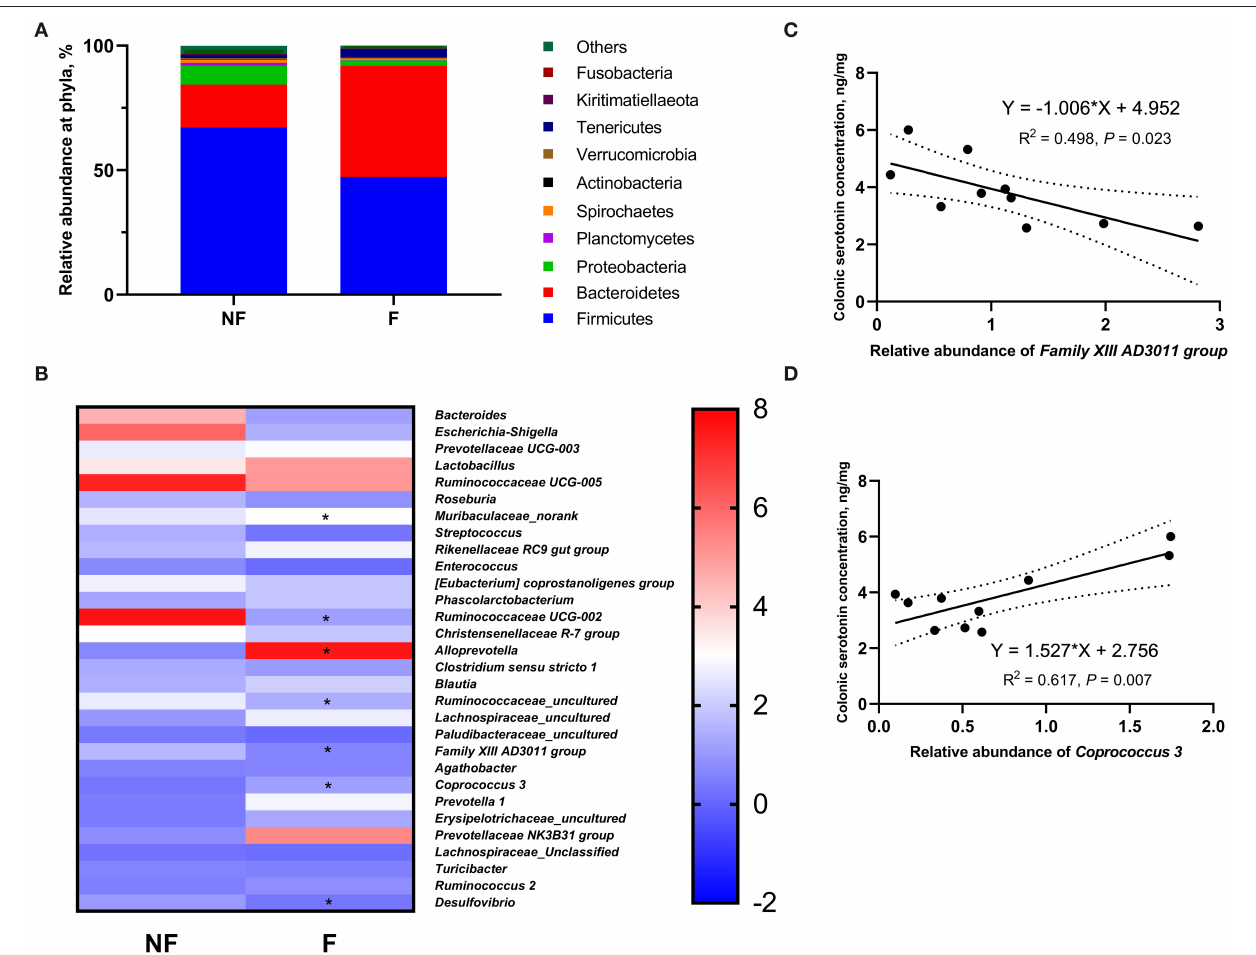
FIGURE 8 | Effects of fiber supplementation in gestation diet on relative abundances of colonic microbiota in sows. (A) Relative abundance of colonic microbiota at phylum level; (B) Relative abundance of colonic microbiota at genus level; (C,D) Correlation analysis between the colonic serotonin concentration and the colonic microbiota that showed significant differences between the two groups. NF, sows fed with a semi-purified basal diet (0.01% dietary fiber); F, sows fed with a semi-purified basal diet supplemented with 8.33 g/kg inulin and 200 g/kg cellulose. n = 5 per group. Significant differences are displayed in the figures by * P <